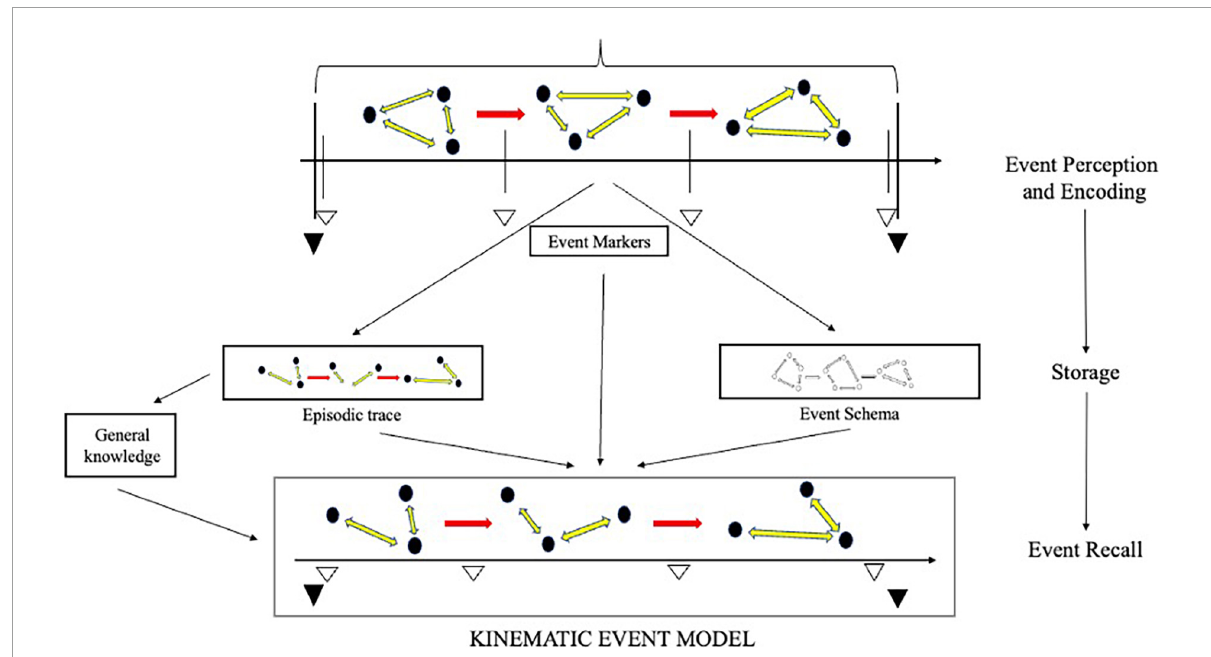
FIGURE3 Event model construction in episodic recall. A kinematic event model is constructed at recall with information from a variety of sources, including episodic traces, event markers, and schemas. How much weight is given to information from the different sources depends on a number of factors; most notably—availability, goals and context. The construction of an event model itself leaves “procedural” traces that can be exploited in subsequent